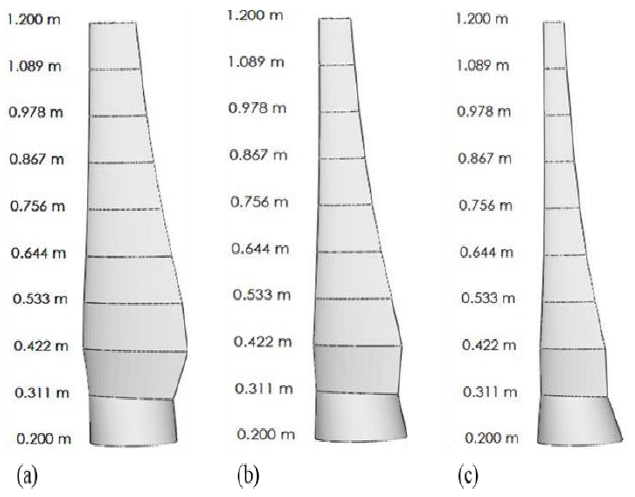
Figure 10. Optimum blade designed with NACA 4412 airfoils for ( a ) TSR 4; ( b ) TSR 5; ( c ) TSR 6.